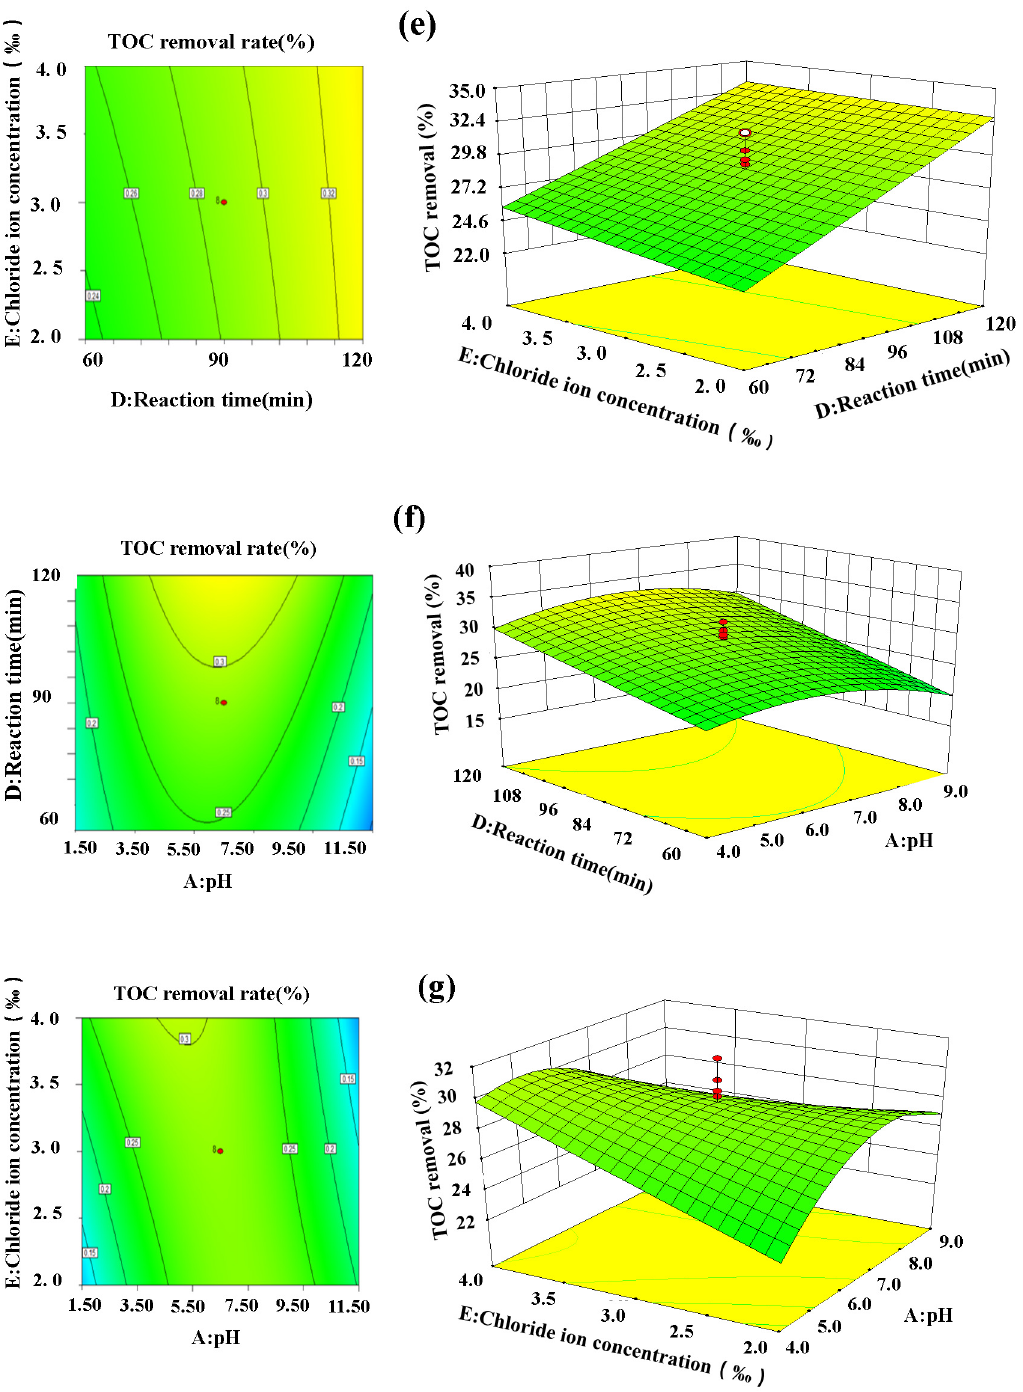
Figure 5. Two-dimensional contour maps ( left ) and three-dimensional response surface diagrams ( right ) of the TOC removal of: ( a ) factors A, B (flow rate, chloride ion concentration, and reaction time of 82.5 mL/min, 3‰, and 90 min, respectively); ( b ) factors A, C (current density, chloride ion concentration, and reaction time of 28.3 A/m 2 , 4‰, and 120 min, respectively); ( c ) factors B, C (initial pH, chloride ion concentration, and reaction time of 6.5, 90 min, and 3‰, respectively); ( d ) factors B, D (initial pH, flow rate, and chloride ion concentration of 6.5, 82.5 mL/min, and 3‰, respectively); ( e ) factors E, D (current density, initial pH, and flow rate of 28.3 A/m 2 , 6.5, and 82.5 mL/min, respectively); ( f ) factors A, D (current density, flow rate, and chloride ion concentration of 28.3 A/m 2 , 82.5 mL/min, and 3‰, respectively); and ( g ) factors A, E (current density, flow rate, and reaction time of 28.3 A/m 2 , 82.5 mL/min, and 90 min, respectively).